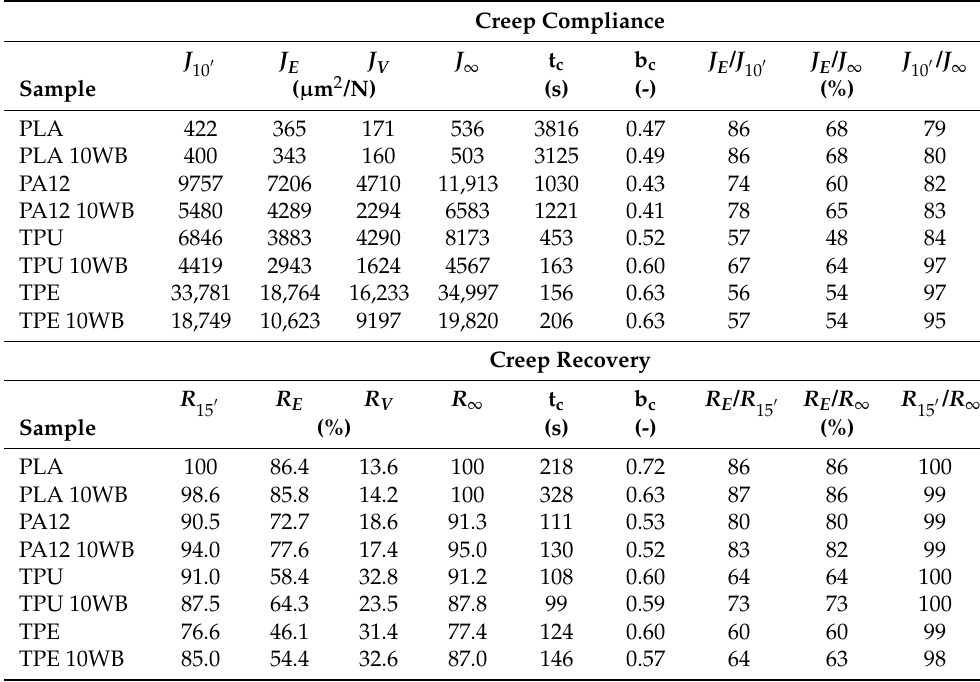
Figure 11. Creep deformation and strain recovery of ( a ) PLA-, ( b ) PA12-, ( c ) TPU-, and ( d ) TPE-based composites. The maximum creep compliance ( J 10 (cid:48) ) and the creep recovery ( R 15 (cid:48) ) observed during tests, as well as the extrapolated parameter of the models, are reported in Table 7. Table 7. Creep compliance and recovery strain: extrapolated and empirical